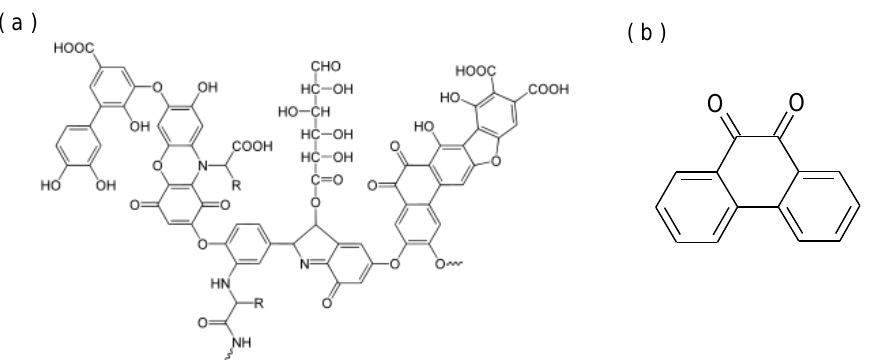
Figure 5. Typical structures of ( a ) HULIS [44] and ( b ) 9,10-phenanthrenequinone (PQN).